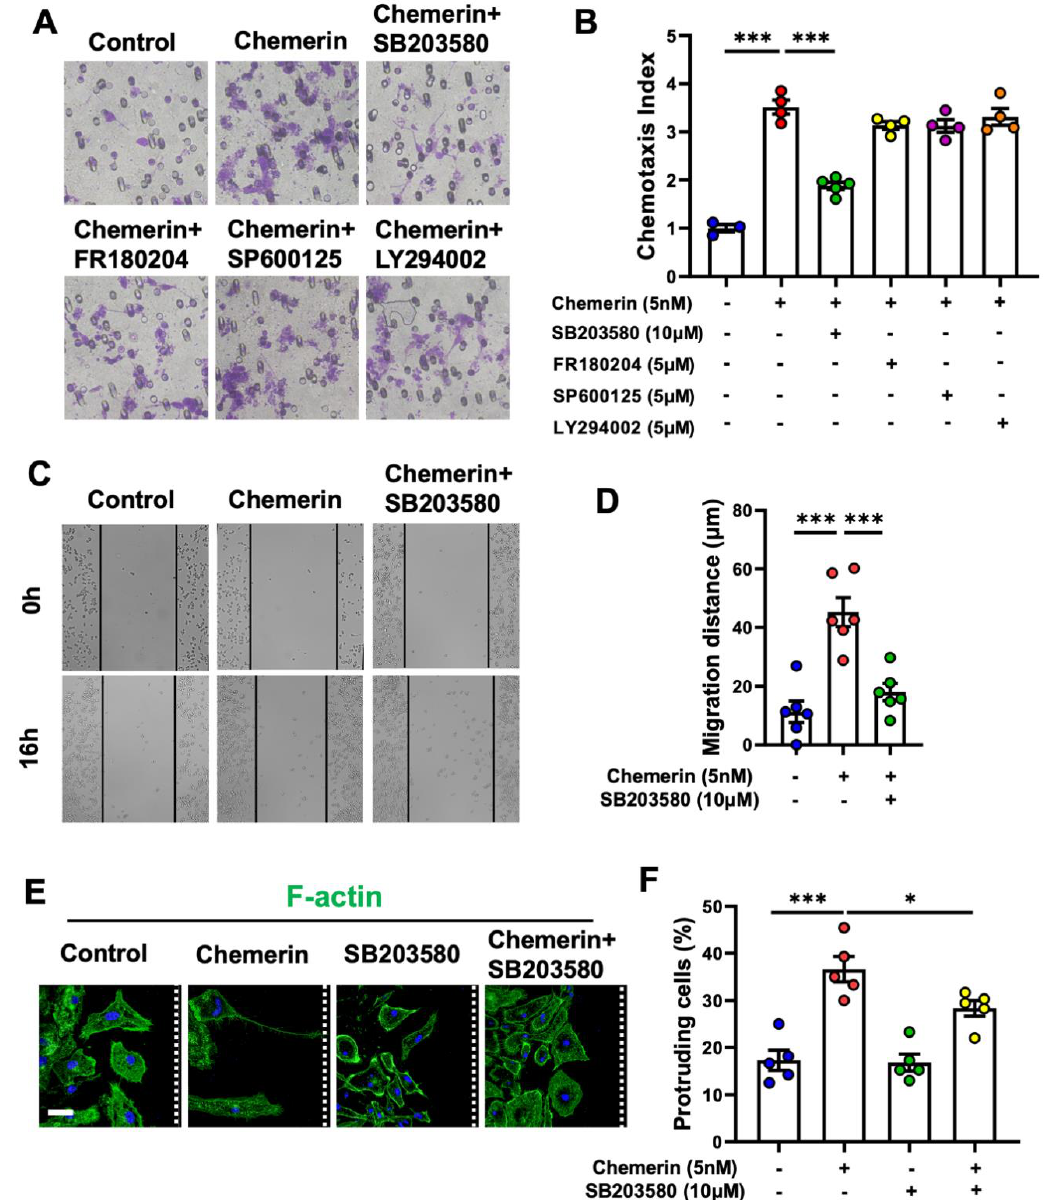
Figure 5. Inhibiting p38 suppresses the promotion of chemerin on the migration and polarization of primary microglia. ( A ) Primary cultures of microglia were incubated with chemerin (5 nM) with or without 15 min pretreatments with SB203580 (10 μM), FR180204 (5 μM), SP600125 (5 μM), and LY294002 (5 μM). After 12 h of incubation, the migration of the cells was detected by 48 -well chem- otaxis chambers. Magnification, × 400. The quantified data are shown in ( B ). Microglial N9 cells were treated with chemerin (5 n M) with or without a 15 min pretreatment with SB203580 (10 μM); then, the migration of microglia was detected by scratch-wound assay. The cells were photographed at 0 h and 16 h. Representative images of migrated cells are shown in ( C ), and quantified data are shown in ( D ). ( E ) Primary microglia were incubated with chemerin (5 nM) with or without a 15 min pretreatment with SB203580 (10 μM) for scratch -wound assay. At 16 h after scratching, the cells were stained with anti-FITC-phalloidin (F-actin, green fluorescence). Cell nuclei were stained with DAPI (blue fluorescence). Scale bar, 50 μm. The white dashed lines indicate the direction of the wound. ( F ) For F-actin staining, primary microglia were scored as protruding when their protru- sions were at least 4 times longer than wide. The results are expressed as the mean ± SEM from three separate experiments, each in at least triplicate. * p < 0.05, *** p < 0.001.